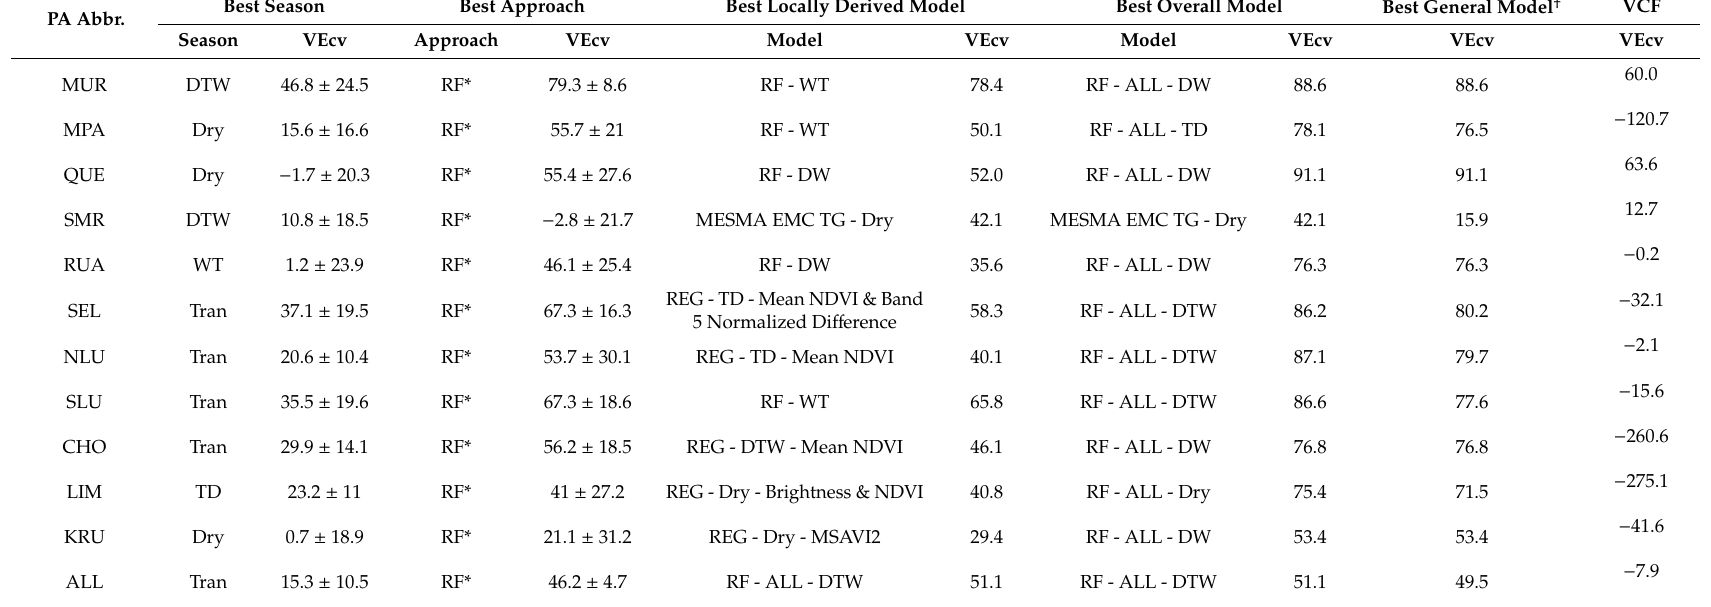
Table 4. Best seasons, approaches, and models as measured by VEcv (%). The best locally derived model refers to those trained using reference data from the respective PA only. The best overall model is that with the absolute highest accuracy, regardless of the source of the training data. The best general model is the single model that did best on average across all the PAs. Model naming structure: Approach - source of training data - image season - variables used in model . We list the source of the training data only when it was ALL—the combination of all the PAs in this study—otherwise the source is the PA itself. Similarly, only models that used individual variables (i.e., regressions; “REG”) list those variables. Standard deviations are given where accuracies are mean values; otherwise, values are the accuracy of the single map produced by the model. Because we did not apply the unmixing approach to all image combinations (only DW), we excluded unmixing results from the best season evaluation, resulting in higher than otherwise expected mean